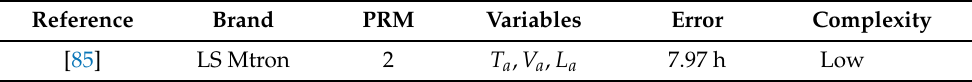
Table 8. Degradation model with electrical-related input for